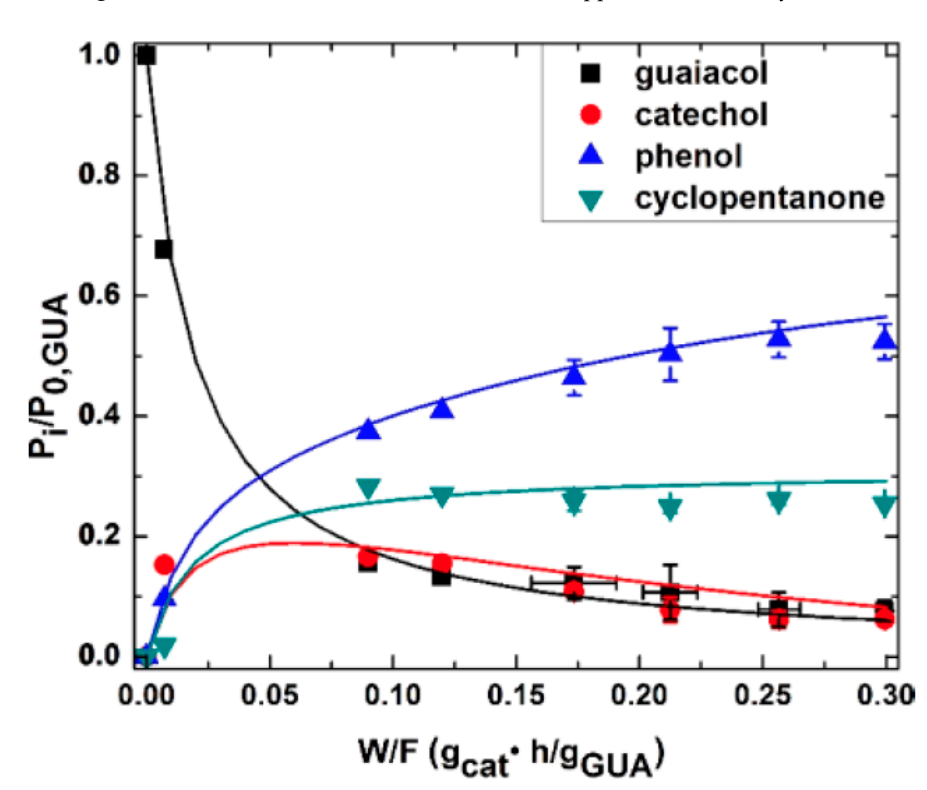
Figure 9. Kinetic for guaiacol HDO over Pt/C catalyst at 300 °C under atmospheric pressure [22].